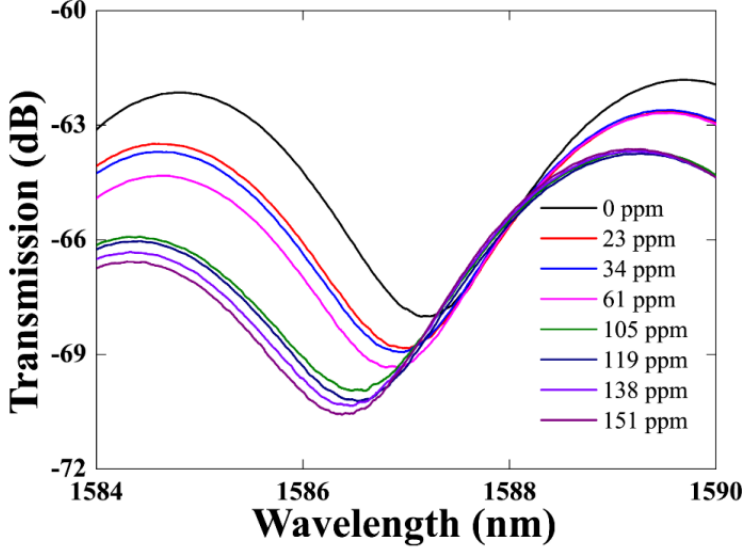
Figure 9. Transmission spectrum of the sensor for ammonia gas concentration from 0 to 151 ppm at temperature of 25 °C.